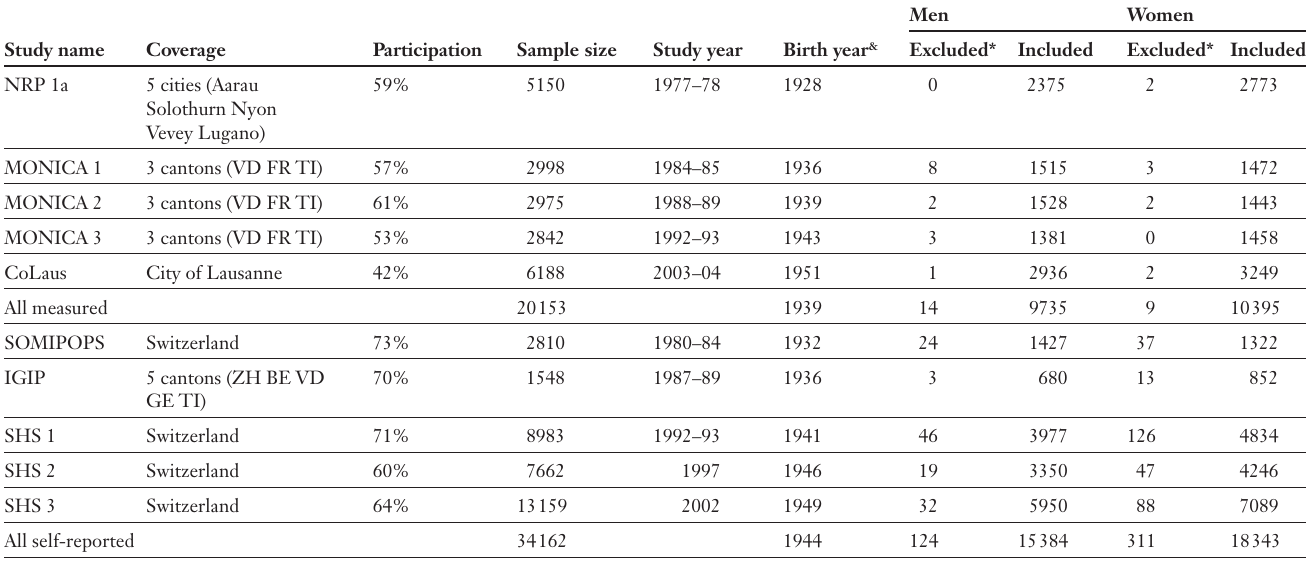
Main characteristics of the study populations (restricted to ages 35–74).